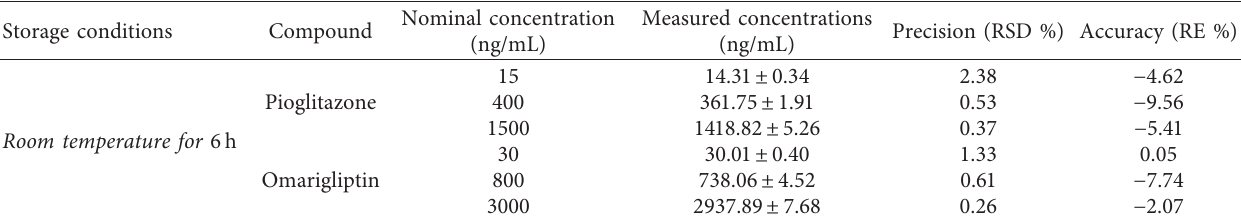
Table 5: Stabilities of pioglitazone and omarigliptin under different conditions ( n � 5). Storage